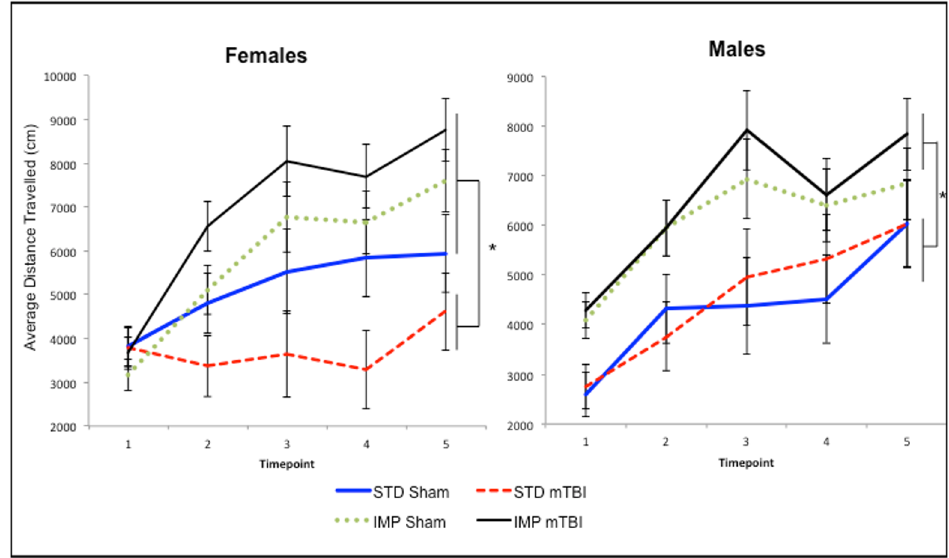
5 distinct time-periods with STD-mTBI females also showing significant reductions in activity when compared to STD-shams ( * main effect of cohort, p <